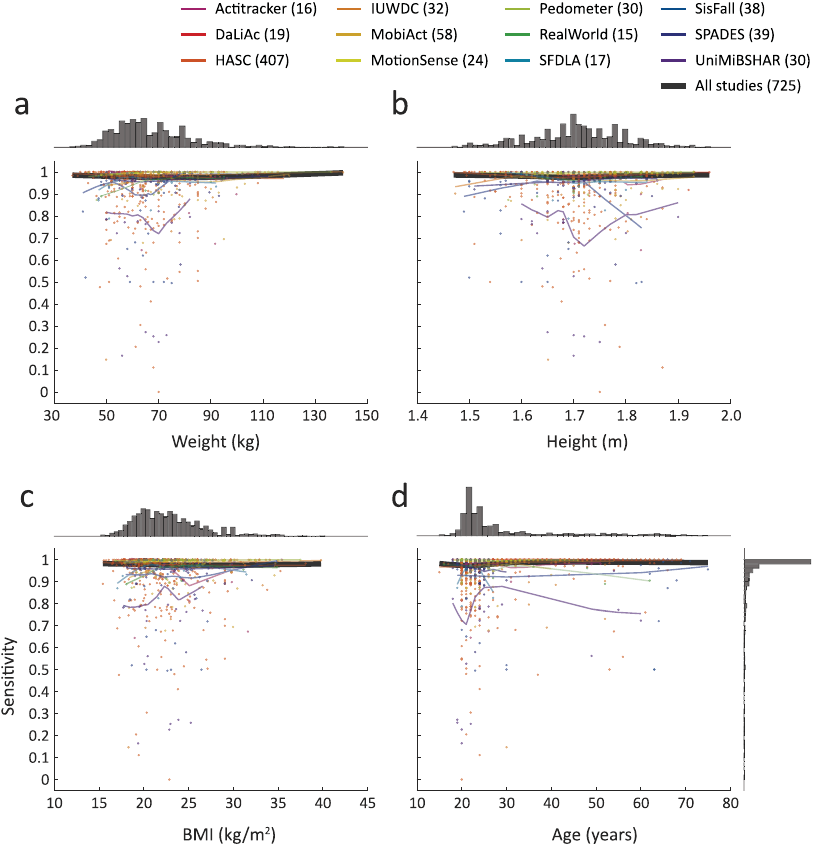
Fig. 6 Bias assessment. Normal walking sensitivity metrics against body measure and demographic covariates of weight ( a ), height ( b ), BMI ( c ), and age ( d ). Each dot represents a metric for one subject averaged across body locations available for this subject and activity repetitions this subject performed. The light curves represent smoothed study-level averages while the black curve is an overall